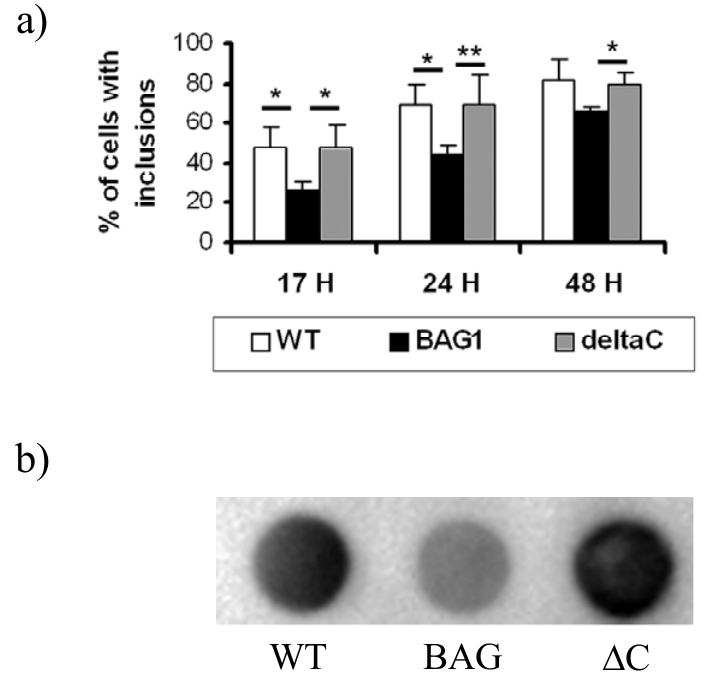
Figure 2. BAG1, but not BAG Δ C decreases mut-htt